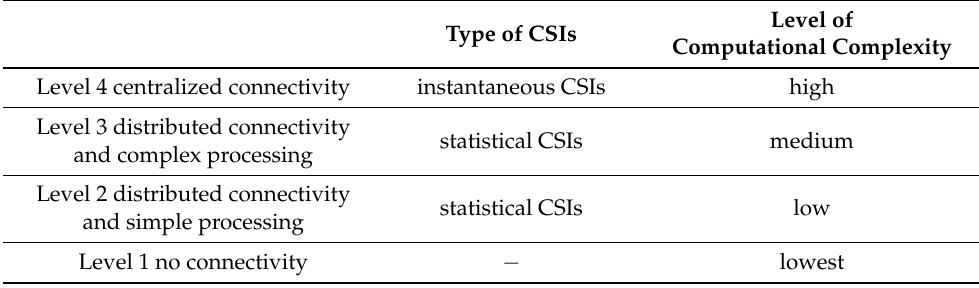
Table 1. Type of CSIs that needs to exchange among CPUs, and the comparison of different levels of